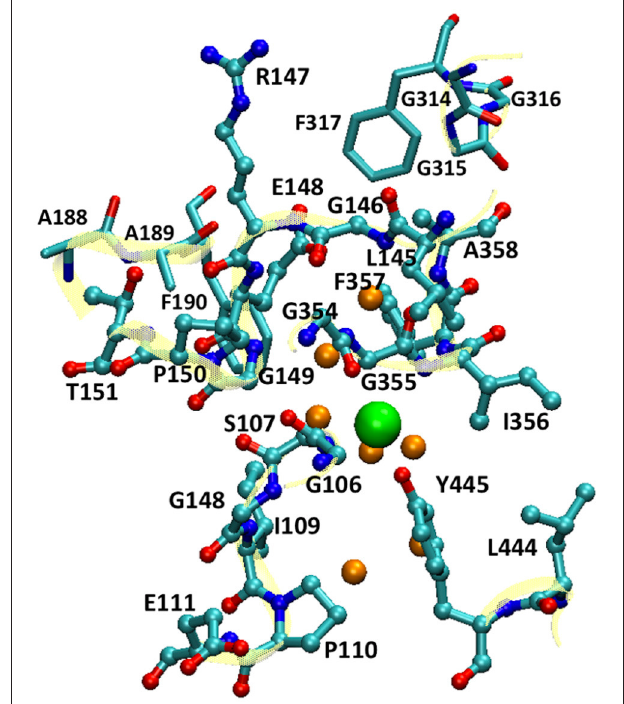
FIGURE 2 | The QM subsystem in QM/MM umbrella sampling simulations. The pore residues are shown as balls and sticks, and the residues near the extracellular pore entrance as sticks (cyan, C; blue N; and red O). The backbones of these residues are illustrated in cartoon in yellow. The Cl − ion is depicted as a large green sphere, and the water molecules in its vicinity as small orange spheres. For clarity, H atoms are omitted.